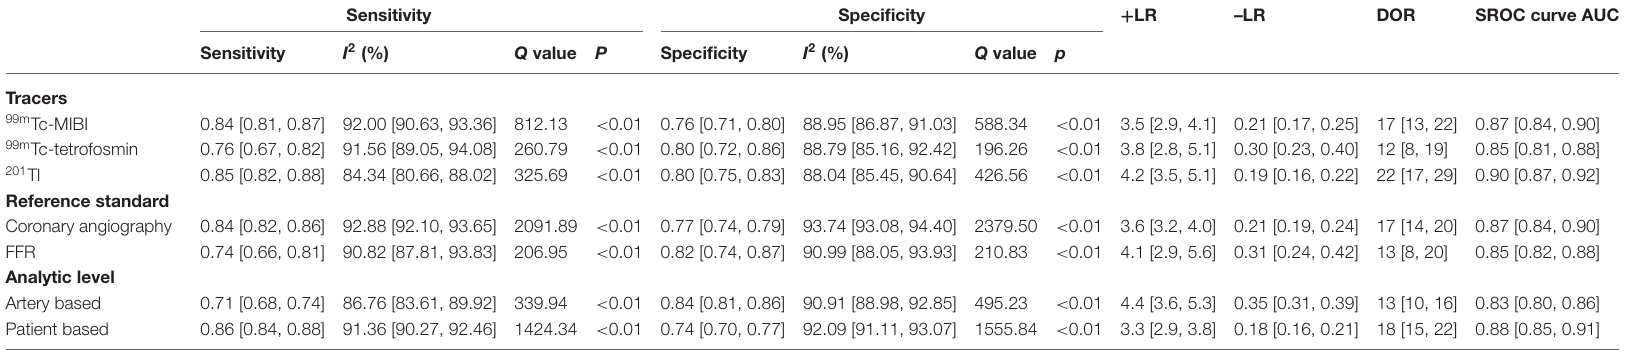
TABLE 3 | Subgroup analysis of SEPCT